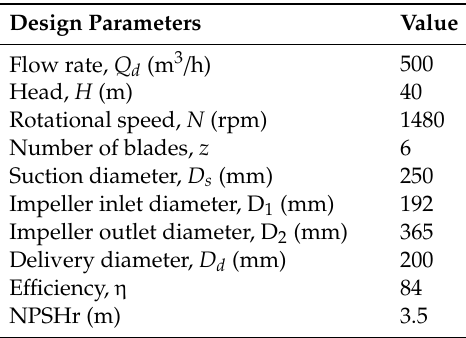
Figure 1. Tested pump and computational domain. Table 1. Design specifications of model pump.